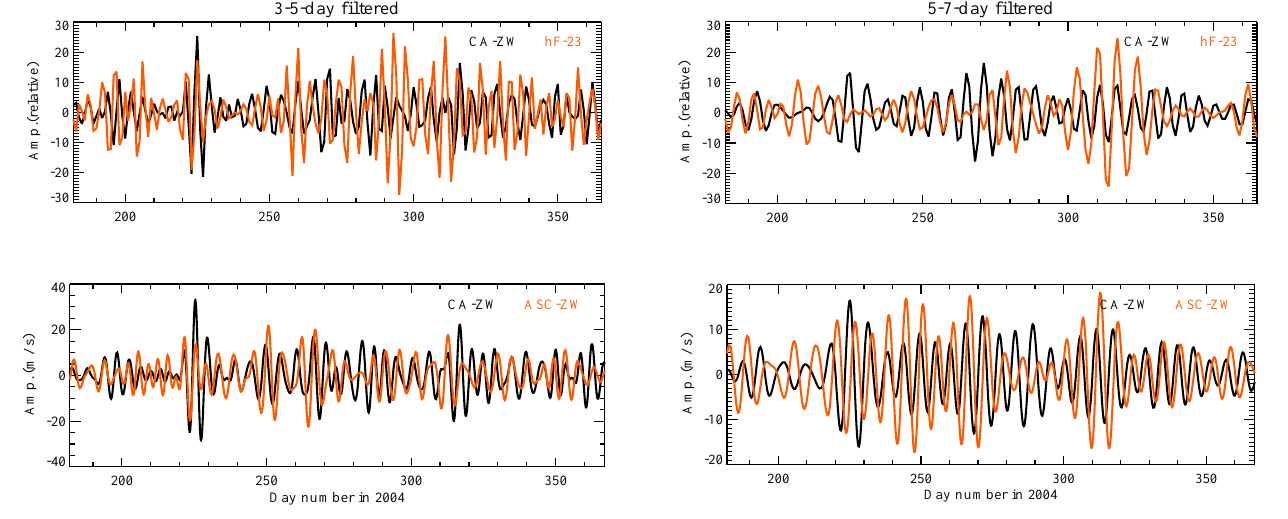
Fig. 6. Amplitude of oscillation of 3–5-day filtered h 0 F at Fortaleza (red line) and zonal wind at Cariri (black line) (top), and zonal wind at Ascension Island (red) and Cariri (black) (bottom). There is no wind data for Ascension from day 275 to day 285.